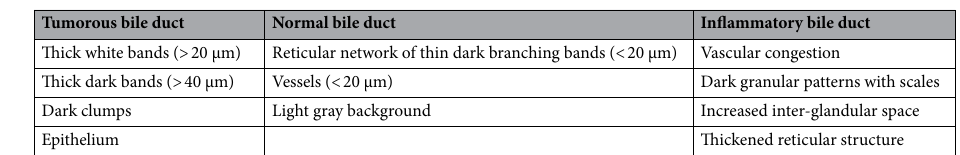
Table 3. Both the Miami-criteria and Paris-criteria for the diagnosis of indeterminate biliary strictures in